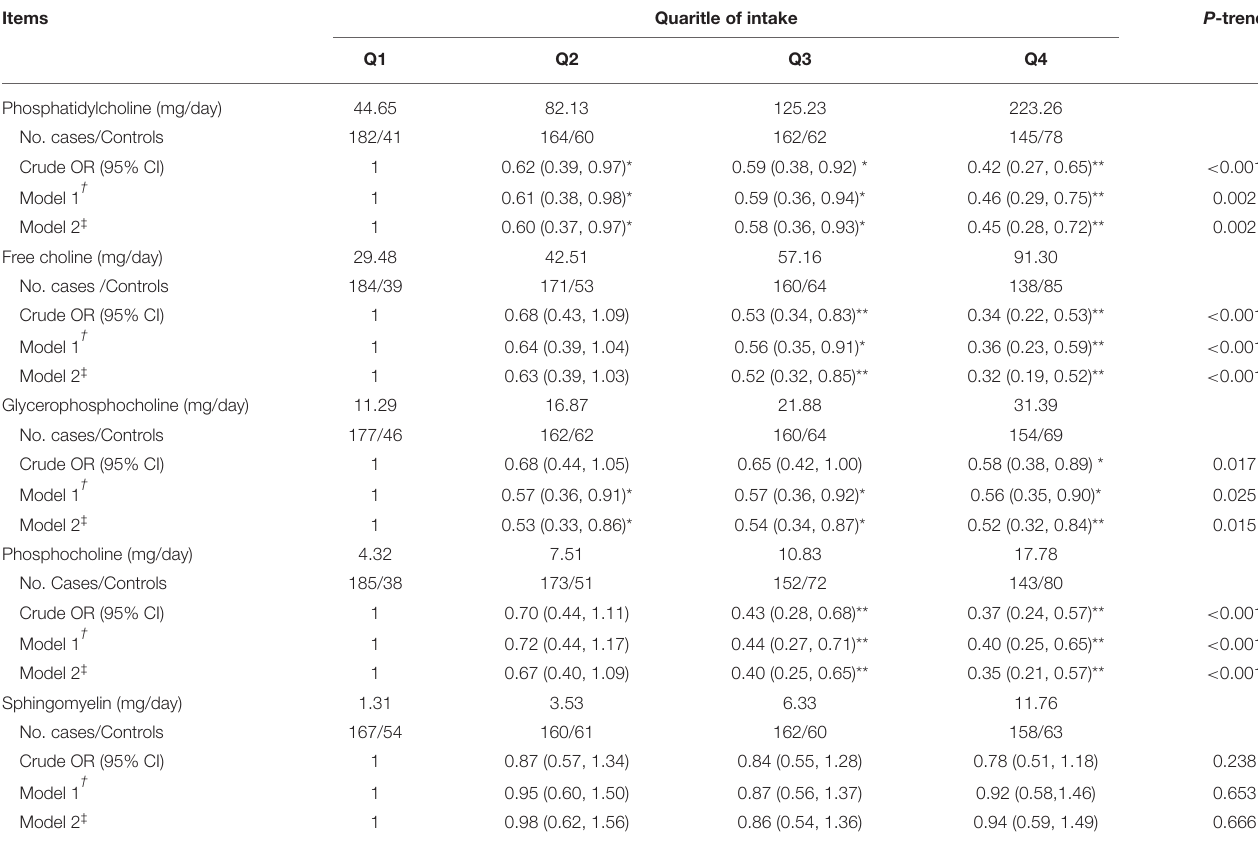
TABLE 4 | ORs and 95% CIs of fluorosis according to quartiles of dietary energy-adjusted five main choline-containing compounds intakes. Items Quaritle of